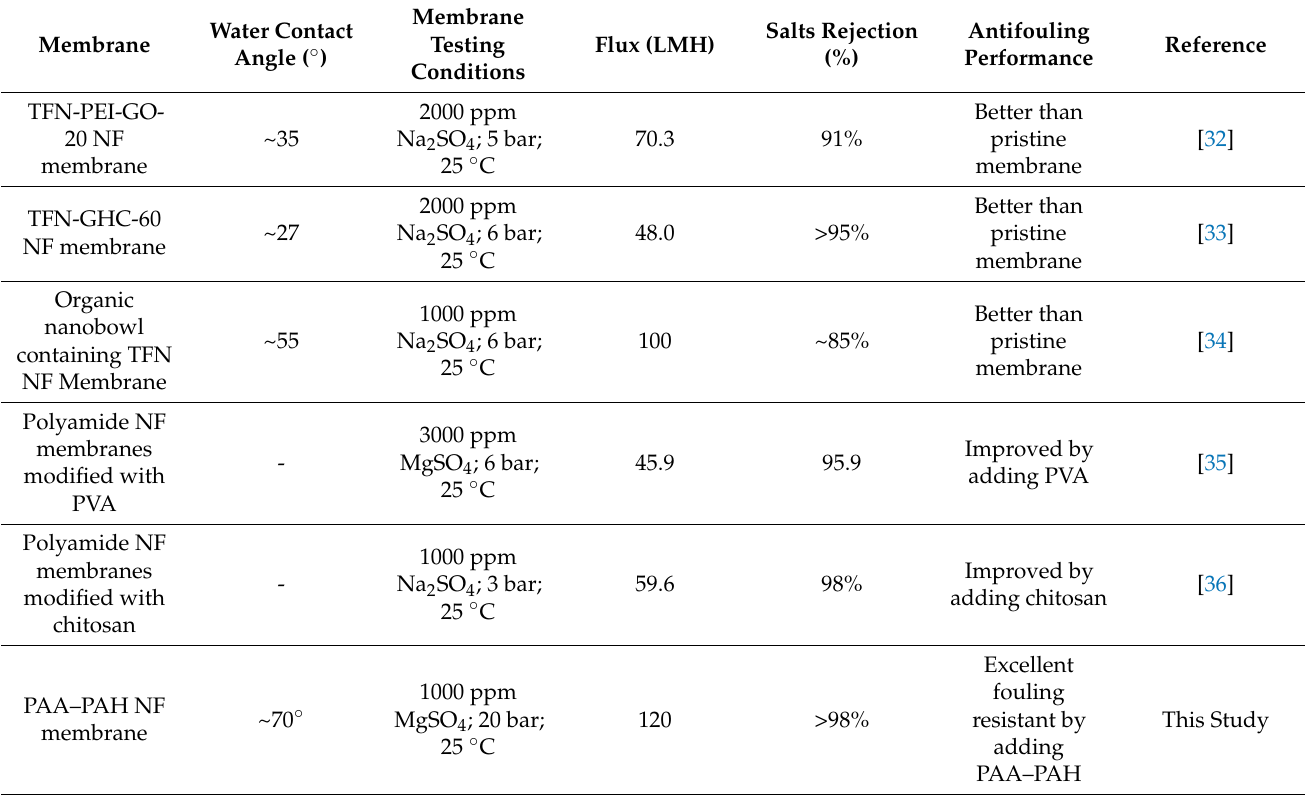
Table 1. Comparison of PAA–PAH modified polyamide NF membrane with other NF